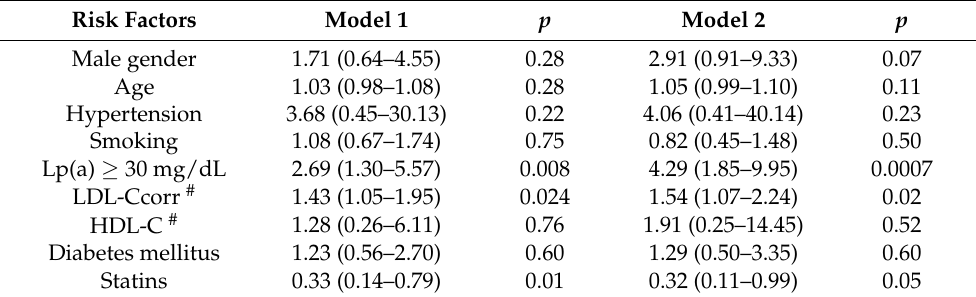
Table 3. Results of multivariate logistic regression analysis of the relationship of hyperLp(a) and other risk factors with the presence of diffuse lesions with calcinosis of coronary arteries.